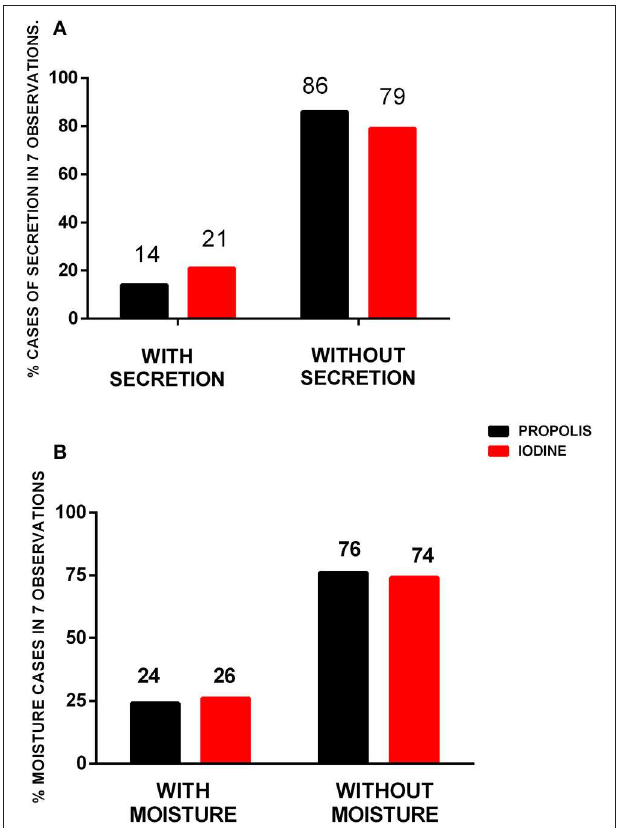
FIGURE 2 | Cases of purulent secretion and moisture in surgical lesions after treatment with propolis or iodine. Percentage of purulent secretion (A) and moisture (B) cases in the surgical wounds in seven observations throughout the 2-month observation period. Data were compared by the odds ratio test, with p < 0.05; no significant difference was found between